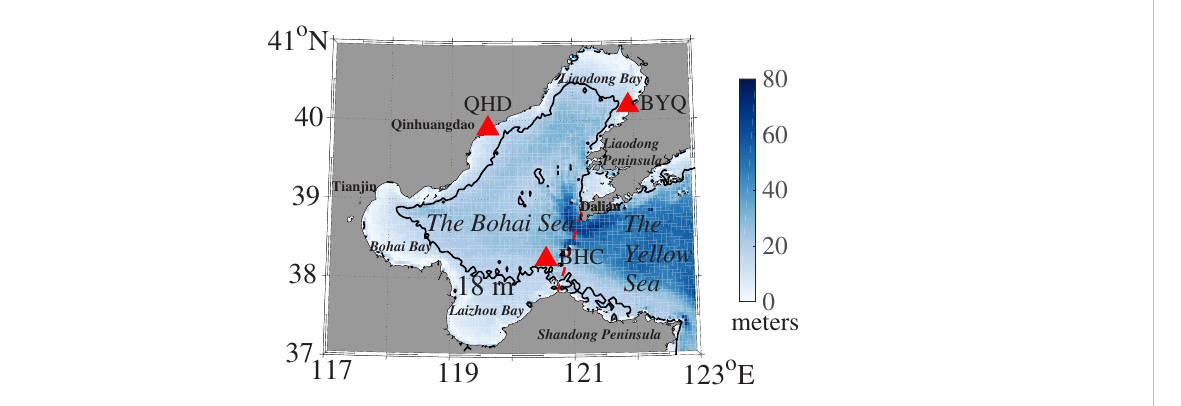
FIGURE 1 Area map and bathymetry in the Bohai Sea. Red triangles denote the long-term oceanographic stations used in the seawater temperature validation including Beihuangcheng (BHC), Qinhuangdao (QHD) and Bayuquan (BYQ); Black contour denotes the isobath of 18 m; Red dash line denotes the boundary of the Bohai Sea and the Yellow Sea.